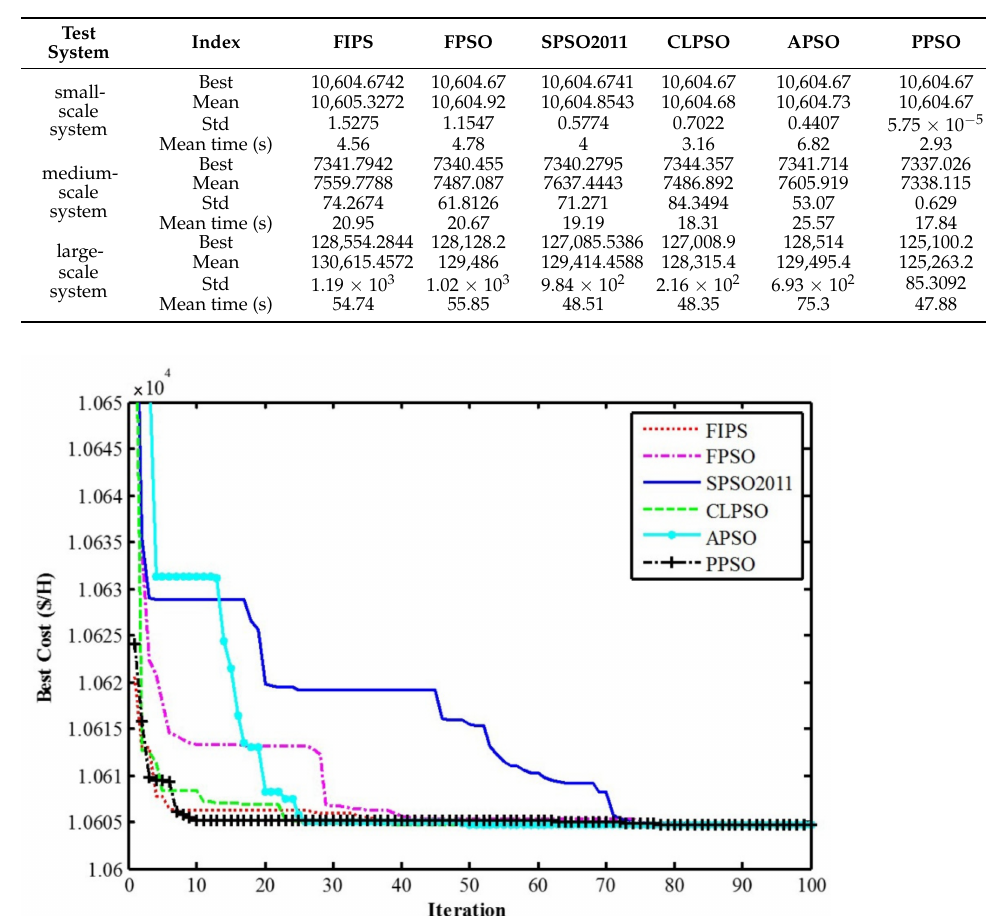
Table 4. Comparing the simulation final results for the multi-area power systems.